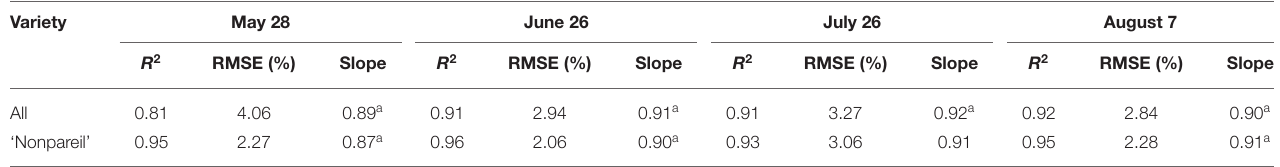
TABLE 3 | Comparison of R 2 , root mean square error (RMSE) (to the 1:1 line), and the regression line slopes (when forcing a zero intercept) between the Virtual Orchard (VO) estimated canopy fractional PAR (fPAR) and mobile lightbar estimated midday canopy fPAR (June 26) over the season in 2019 at the per-row level. Variety